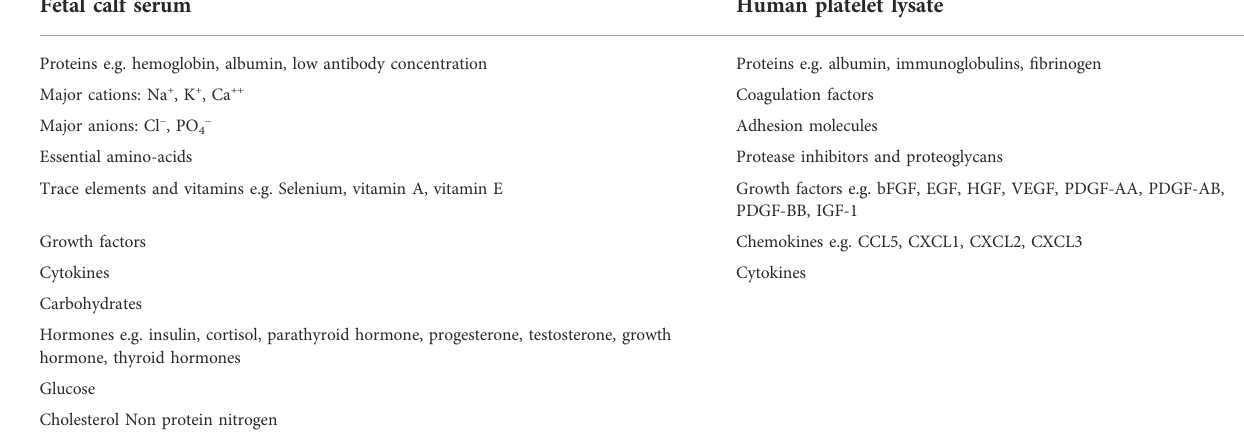
TABLE 1 Overview of the different components of FCS and PL as culture medium growth supplement. This list is non-exhaustive and based on previously published data (Price and Gregory, 1982; Horn et al., 2010; Crespo-Diaz et al., 2011; Kinzebach et al., 2013; Shih and Burnouf, 2015; Pilgrim et al., 2022). (bFGF = basis fi broblast growth factor, EGF = epidermal growth factor, HGF = hepatocyte growth factor, VEGF = vascular endothelialgrowthfactor,PDGF=plateletderivedgrowthfactor,IGF=insulinlikegrowthfactor,CCL=chemokine(C-Cmotif)ligand,CXCL=C-X-C motif chemokine